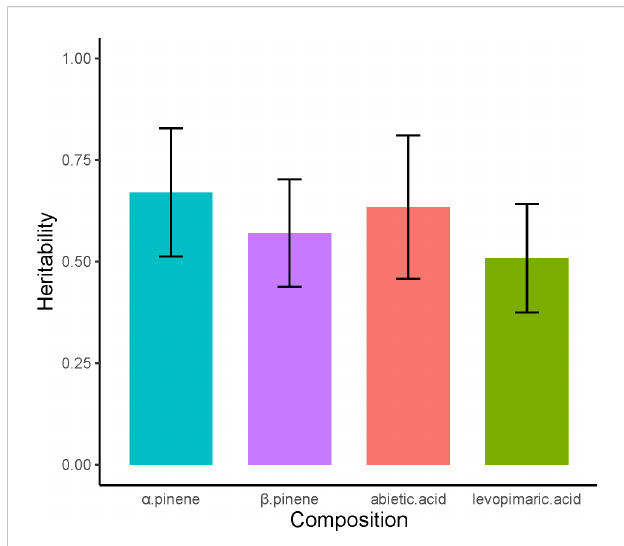
FIGURE 2 Heritability of a pinene, b pinene, abietic acid and levoprimaric acid. The red line at the top of each column shows the margin of standard error for